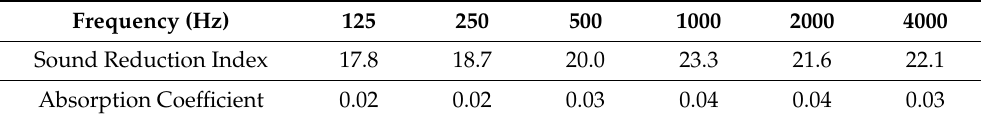
Table 2. Sound Reduction Index and absorption coefficient of the door between bedroom and